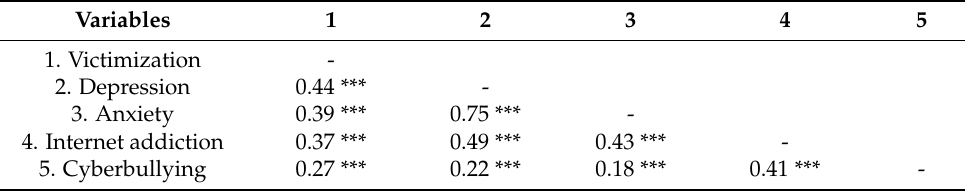
Table 2. Correlations among all latent constructs in this study.